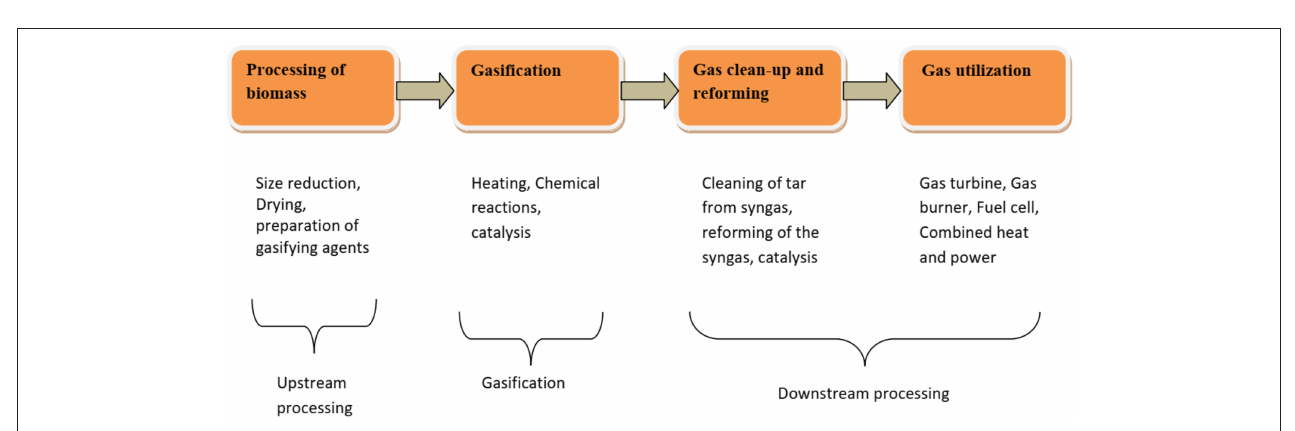
FIGURE 10 | Steps involved in gasification of biomass (Kumar et al., 2009).